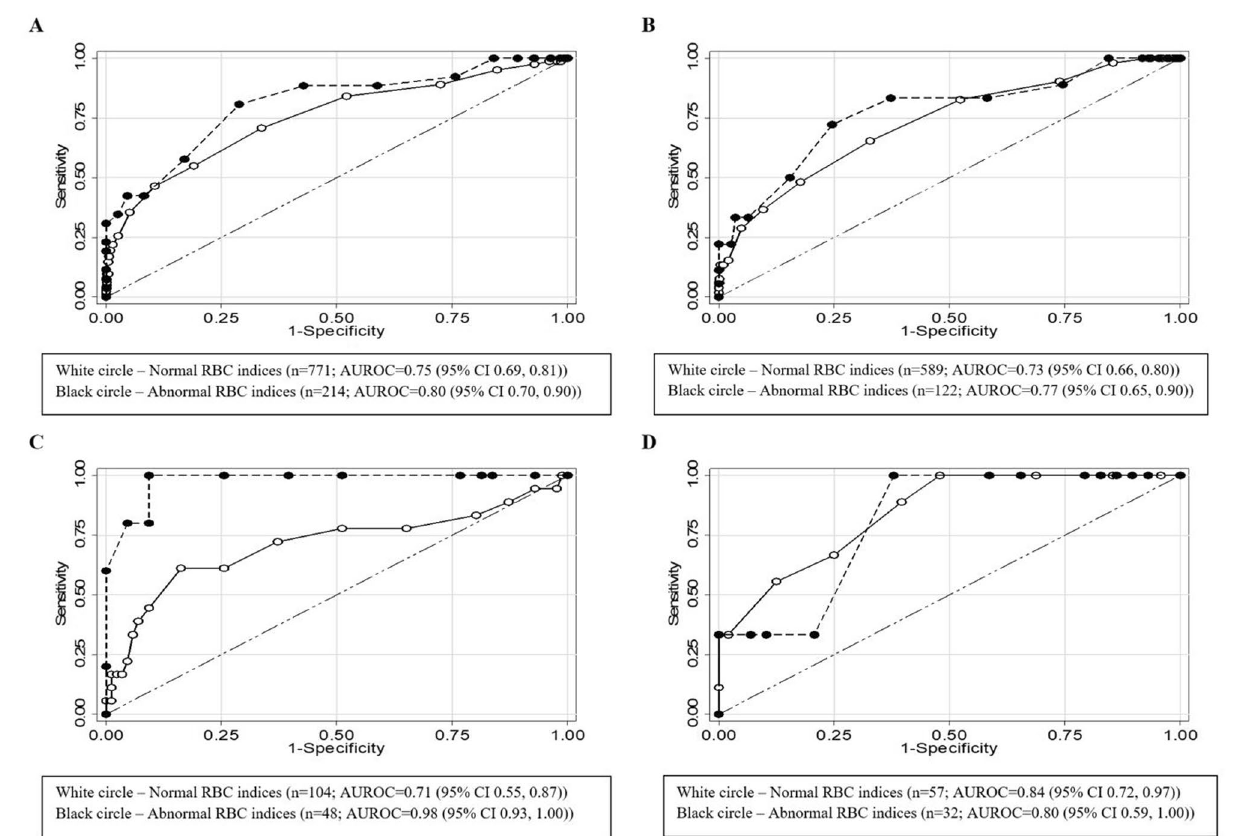
Figure 1. ROC curves for HbA1c in detecting dysglycaemia among women of ( A ) all ethnicities, ( B ) Chinese ethnicity, ( C ) Malay ethnicity, and ( D ) Indian ethnicity, from the S-PRESTO study. The dotted diagonal line represents AUROC of 0.5, which suggests no discrimination. AUROC area-under-receiver-operating- characteristic curve, CI confidence interval, HbA1c glycated haemoglobin, RBC red blood cell, ROC